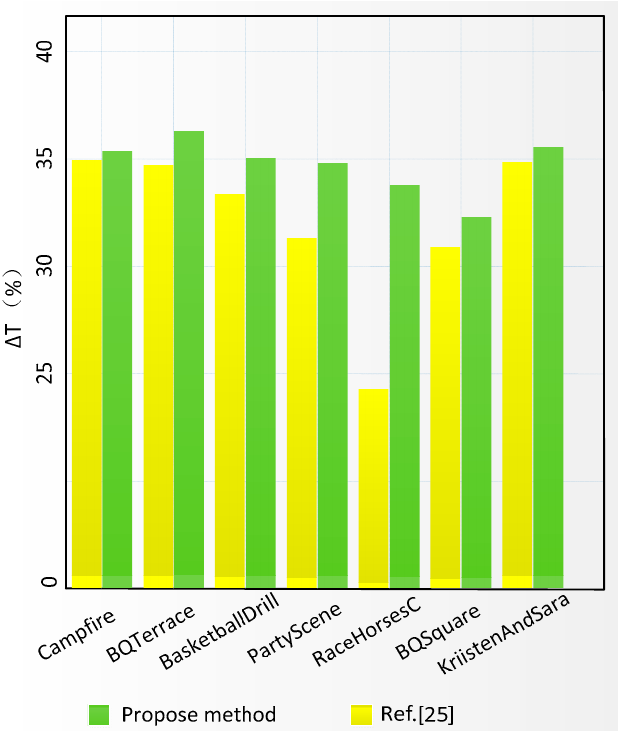
12 Table 3. Coding performance of the proposed algorithm. Class